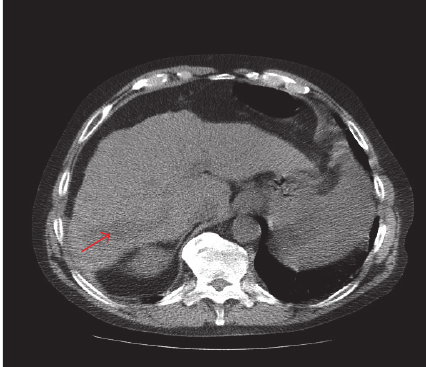
Figure 3: CT abdomen showing right hepatic lobe mass.